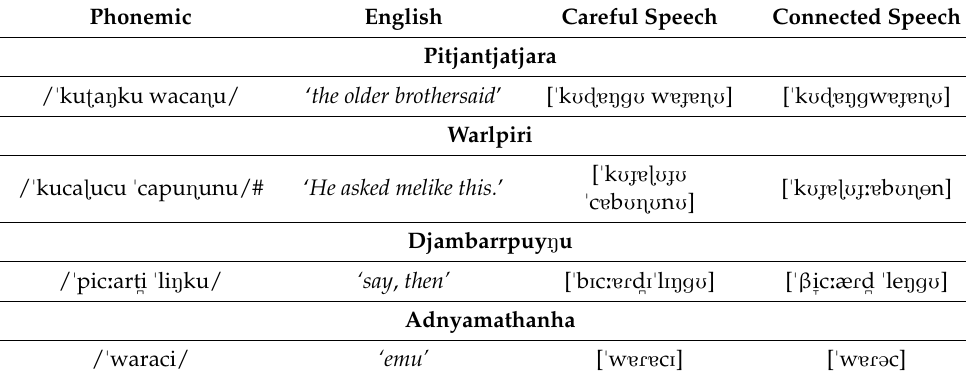
Table 5. Examples of final vowel deletion in Pitjantjatjara, Warlpiri, Djambarrpuy N u, and Adnya- mathanha, adapted from Butcher (2008).